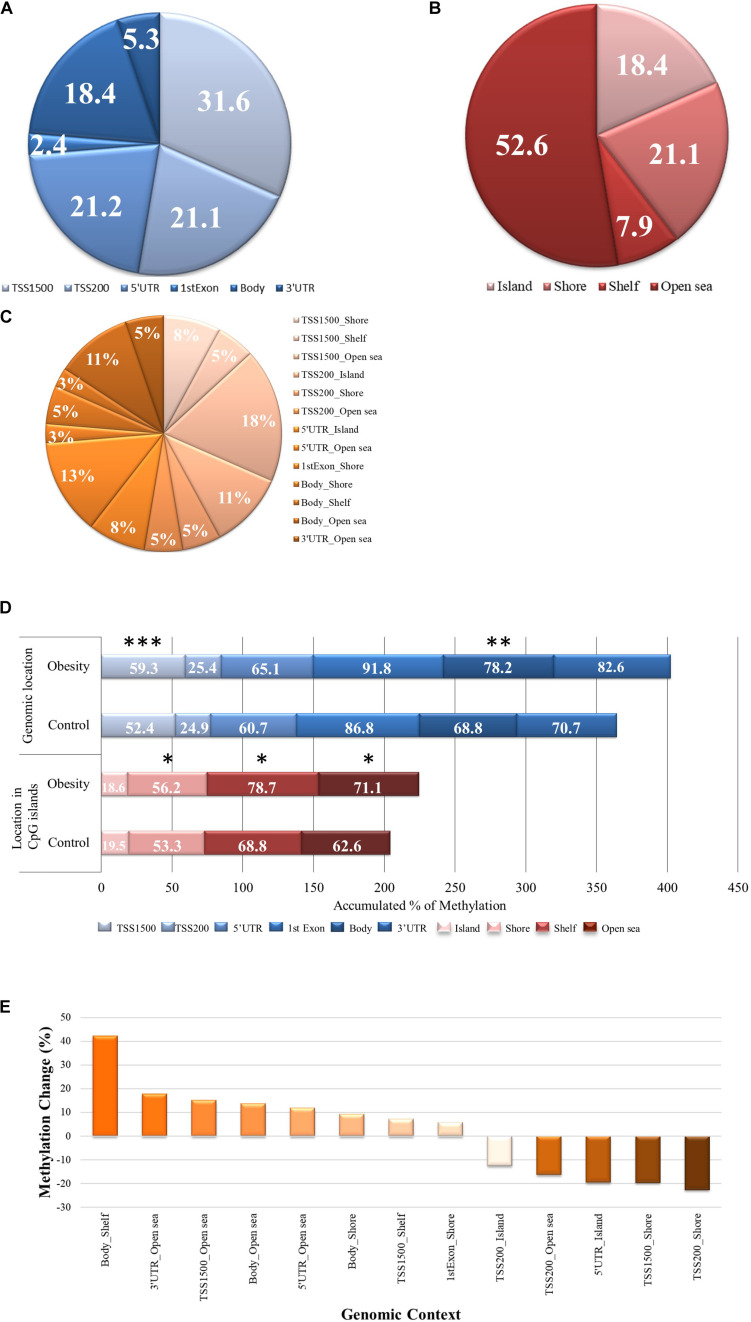
The CpGs methylation levels according to gene localization, localization in the CpG island and genomic context. (A) A pie chart showing the proportions of individual CpG sites according gene localization (B) A pie chart showing the proportions of individual CpG sites according localitzation in CpG island (C) A pie chart showing the proportions of individual CpG sites according genomic context (D) DNA methylation representation for individual CpG sites for all the studied gene localizations (TSS1500, TSS200, 5’UTR, 1stExon, Body, and 3’UTR) and localizations in CpG islands (island, shore, shelf and open sea) in gestational obesity and control group, using horizontal stacked graph bars. (E) A bar chart depicting the change in methylation percentage in gestational obesity in relation to the control group and according to genomic context. Each CpG site on the array is annotated to a genomic location (TSS1500, TSS200, 5′UTR, 1stExon, Body, and 3′UTR) and a location in the CpG Island (island, shore, shelf, and open sea) region. These were combined for each probe to form a unique genomic context annotation. *p < 0.0001; **p = 0.003, and ***p = 0.001. TSS, transcription start site; UTR, untranslated region.